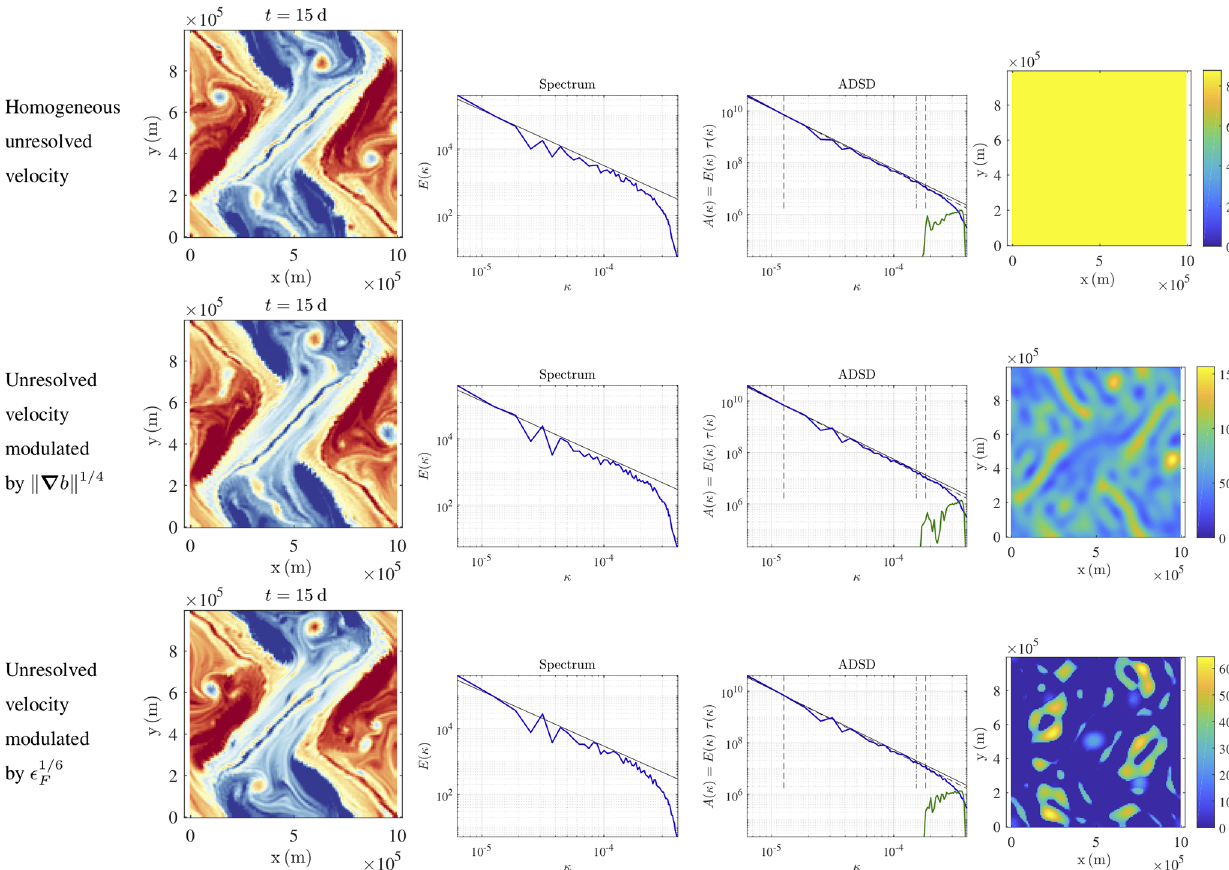
Figure 4. Presented from left to right are the buoyancy field (ms − 2 ), KE spectrum (m 2 s − 2 / (radm − 1 )), ADSD (m 2 s − 1 / (radm − 1 )), and variance tensor at t = 15d for 128 2 -resolution stochastic dynamics with (from top to bottom) homogeneous unresolved velocity, unresolved velocity modulated by (cid:107) ∇ b (cid:107) 1 / 4 , and unresolved velocity modulated by (cid:15) 1 / 6 . This particular initial condition corresponds to case 2 studied F by Constantin et al. (1994, 1999, 2012) at a resolution of 128 2 . The low-resolution stochastic simulations do not show too many filaments and show enough eddies. Among the stochastic simulations, the energy-flux modulation better preserves the sharp straight fronts (e.g. front from (0m, 2 × 10 5 m) to (2 . 5 × 10 5 m, 5 × 10 5